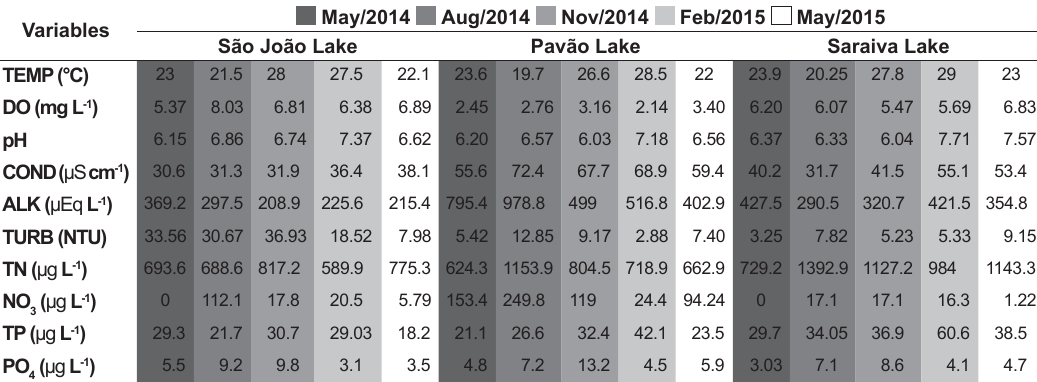
Figure 3. Spatial and temporal variation in species richness of periphytic algae by classes in the sampling sites of the Upper Paraná River floodplain. Saraiva August (Aug/2014), November (Nov/2014), February (Feb/2015). Table 1. Means (n = 2) of limnological variables analyzed in lentic environments of the Upper Paraná River floodplain in different sampling periods. Water temperature (TEMP), Dissolved oxygen (DO), pH, Conductivity (COND), Alkalinity (ALK), Turbidity (TURB), Total Nitrogen (TN), Nitrate (NO ), Total Phosphorus (TP), 3 Orthophosphate (PO 4